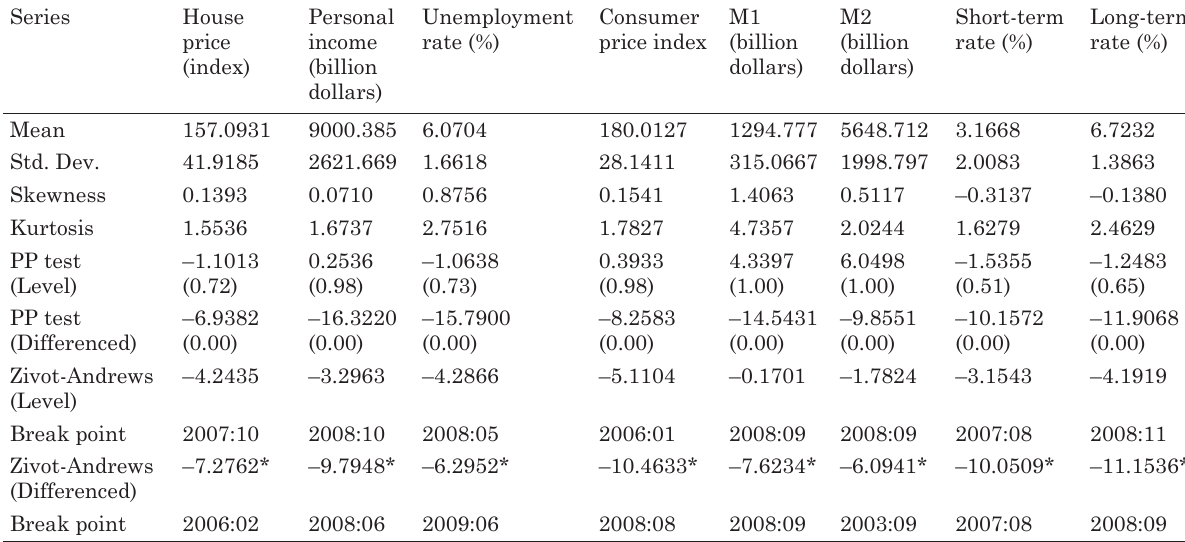
Table 1. Descriptive